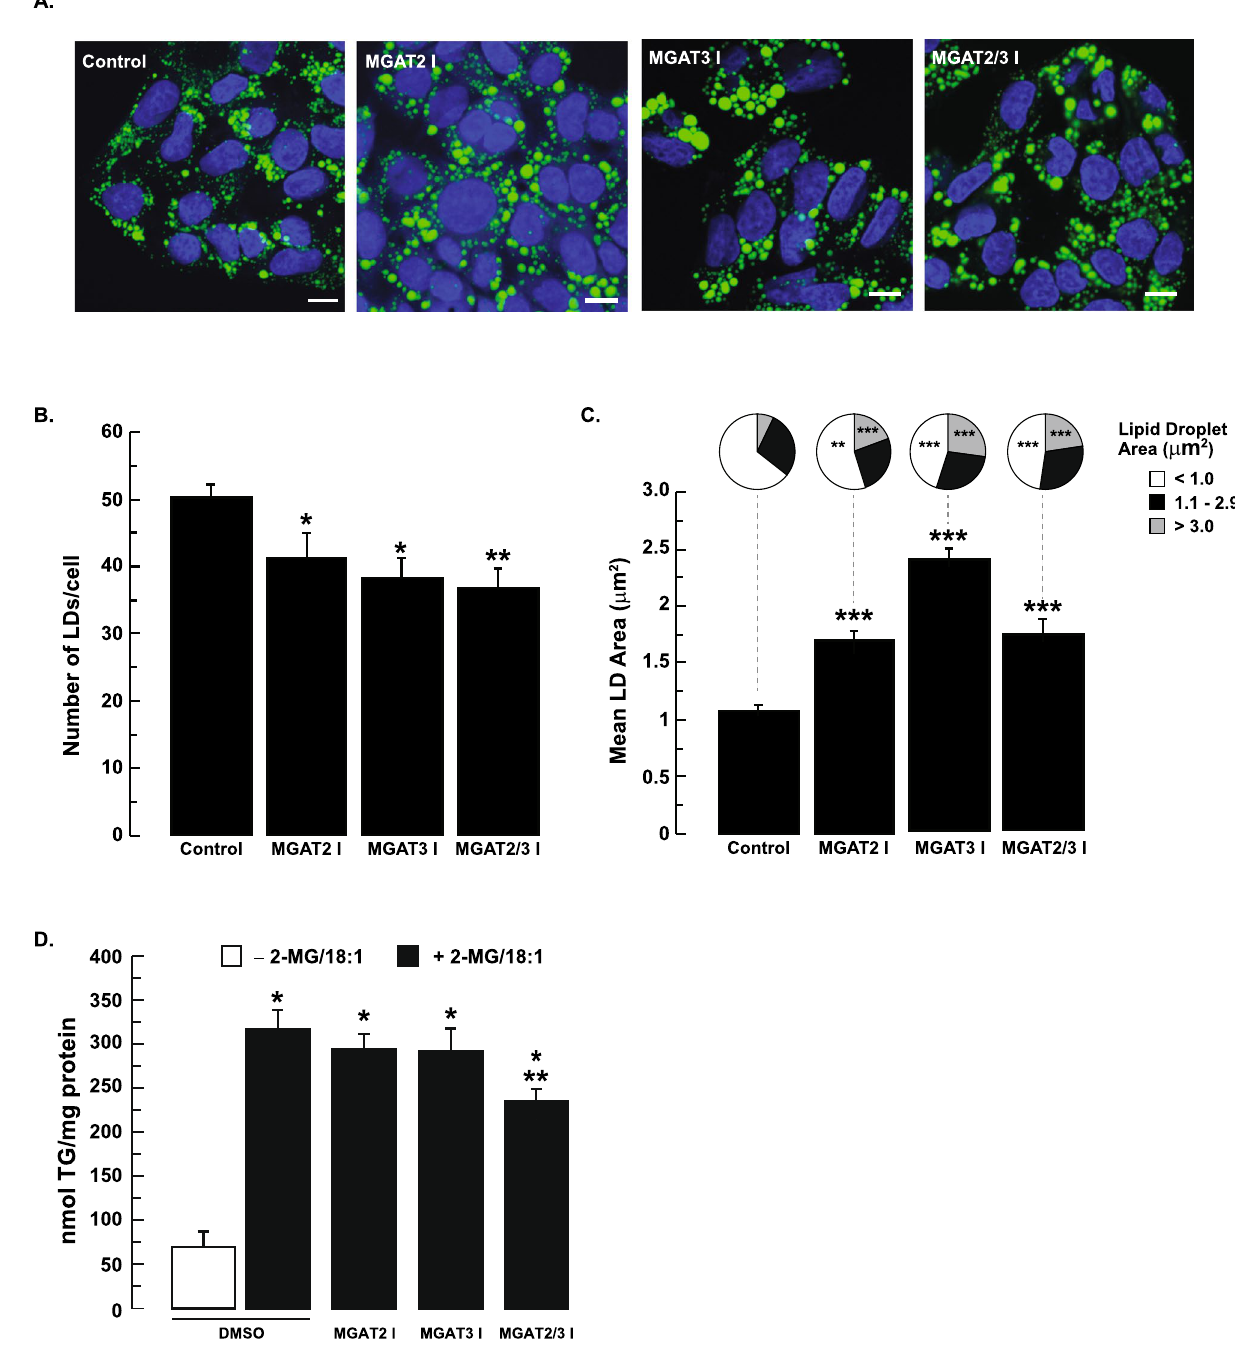
Figure 2. Inhibition of MGAT2 or MGAT3 alters lipid droplet morphology. ( A ) HepG2 cells were pre- incubated with 50 µM MGAT2 inhibitor or 100 µM MGAT3 inhibitor or both together for 2 h. Cells were then incubated with 0.5 mM oleic acid and 0.2 mM 2-MG for 12 h in the presence of the MGAT inhibitors. Cells were fixed and stained with Bodipy 493/503 and DAPI to visualize lipid droplets and nuclei, respectively. Scale bars, 10 µm. Lipid droplet number ( B ) and area ( C ) were quantified using ImageJ (National Institutes of Health, rsb.info.nih.gov/ij). Mean lipid droplet area per cell and lipid droplet number were calculated from 20 to 29 cells. Data are shown as means ± standard error. Size distribution of individual lipid droplets are shown as pie charts. Means were compared by ANOVA followed by Bonferroni Multiple Comparisons Test. * p < 0.05 versus DMSO- treated cells; ** p < 0.01 versus DMSO-treated cells; *** p < 0.001 untreated versus DMSO-treated cells. ( D ) Intracellular TG levels in HepG2 cells are modestly reduced only when both MGAT2 and MGAT3 are inhibited. HepG2 cells were pre-incubated with the MGAT inhibitors or DMSO for 1 h. This was followed by incubating HepG2 cells with 0.2 mM 2-MG and 0.25 mM oleic acid (OA) in the presence of the MGAT inhibitors for 12 h. Cell extracts were prepared, and an aliquot was used for TG determination. * p < 0.001 versus DMSO-treated cells (without 2-MG/OA); ** p < 0.001 versus DMSO-treated cells (with